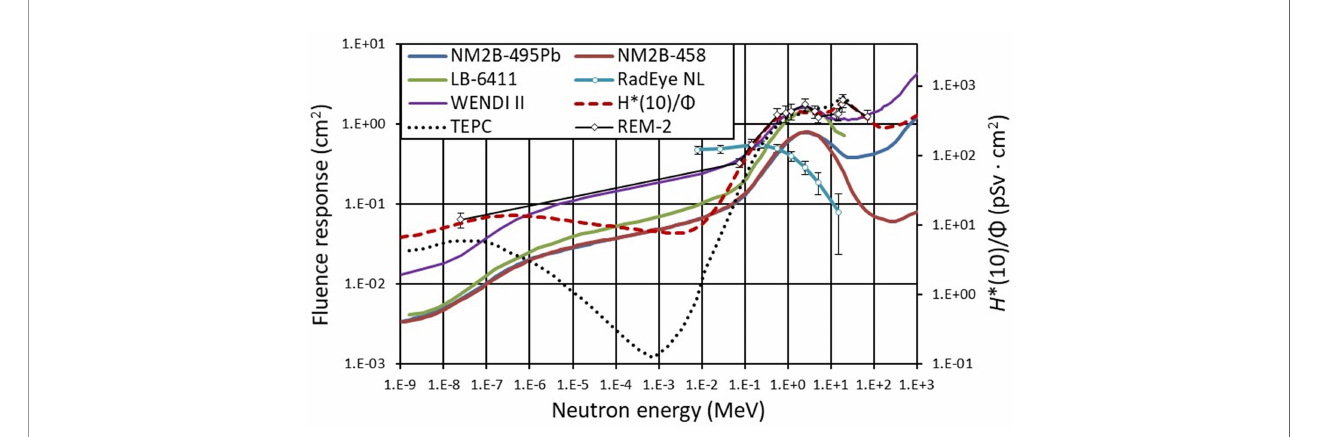
FIGURE 4 | Neutron fl uence response functions of rem counters NM2B-495Pb and NM2B-458 (25), Berthold LB-6411 (26), Wendi II (27), RadEye NL (28), TEPC (29), and REM-2 (30). Dashed line (red) represents H *(10) conversion coef fi cients for neutrons radiation versus neutron energy following ICRP74 recommendation (31) extended to high-energy neutrons according to Pelliccioni (32). The lines connect the points as a guide to the